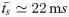
Dwell time-distribution determined by optical trapping.The undifferentiated dwell-time distribution P(Δu) is represented by the black dots. The error bars indicate uncertainties in the measurement and the red line is the fit to P(Δu) using the inverse Gaussian distribution. The shaded area marks the short-time detection limit ts¯≃22ms discussed in the main text. The inset is a log-log plot of P(Δu) vs. Δu for small intervals. It shows that P(Δu) scales as Δu2.